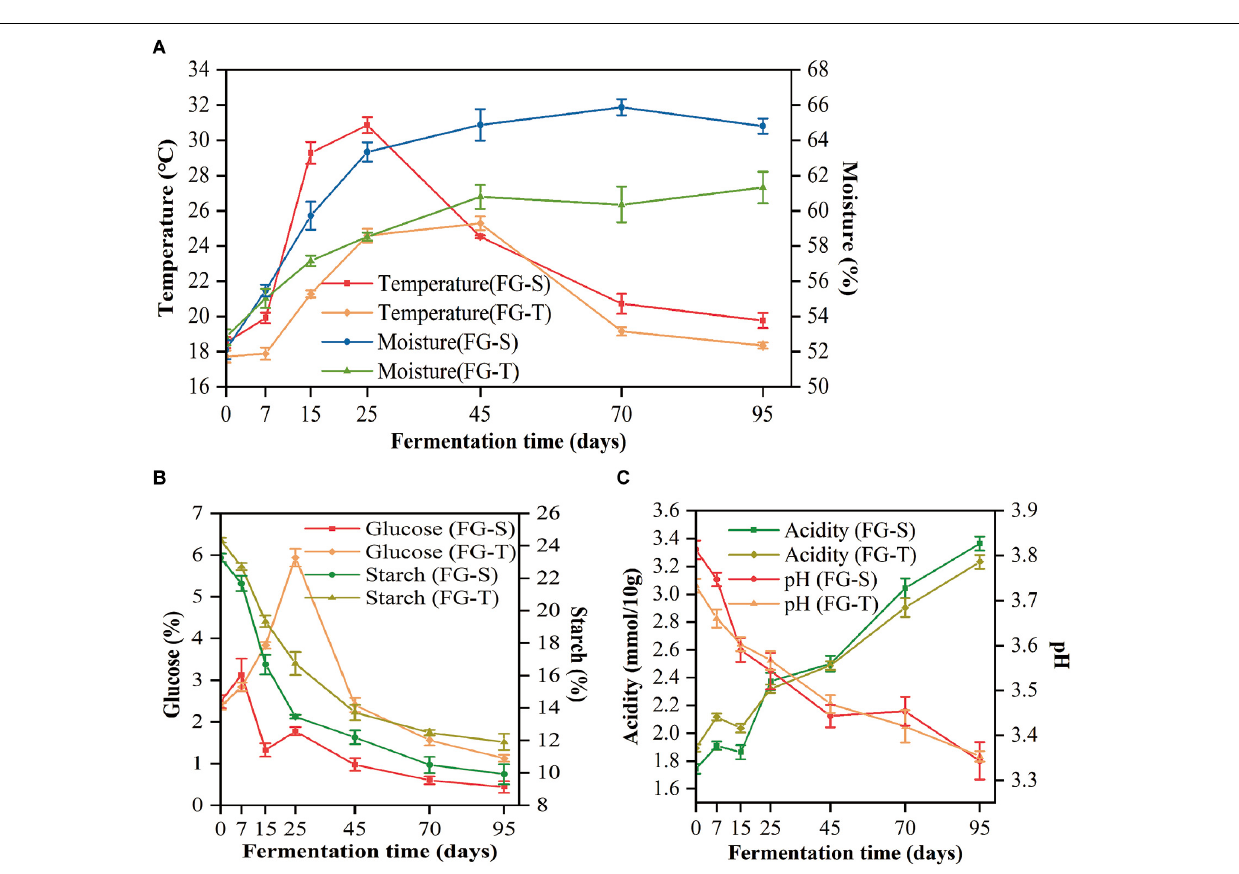
Orders of Lactobacillales , Enterobacteriales , Bacillales , Eurotiales , and Saccharomycetales dominated (average relative abundances > 10%) the initial FG community in both SCSSF and TCSSF